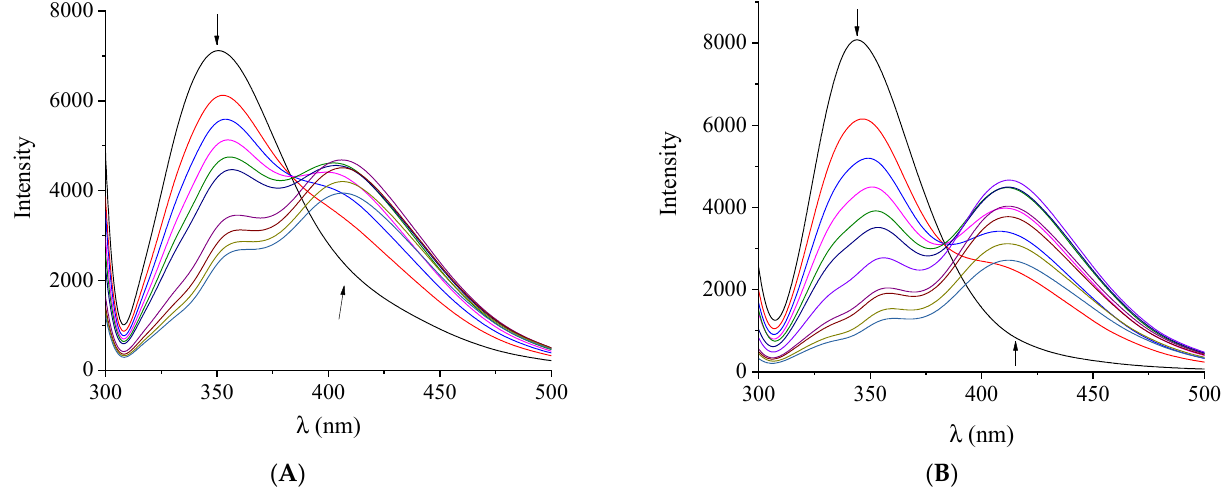
Figure 5. Fluorescence emission spectra ( λ excitation = 295 nm) of a buffer solution (150 mM NaCl and 15 mM trisodium citrate at pH 7.0) containing ( A ) HSA (3 μ M) upon addition of increasing amounts of complex 1 , and ( B ) BSA (3 μ M) upon addition of increasing amounts of complex 2 . The arrows show the changes in intensity upon increasing amounts of the complex.